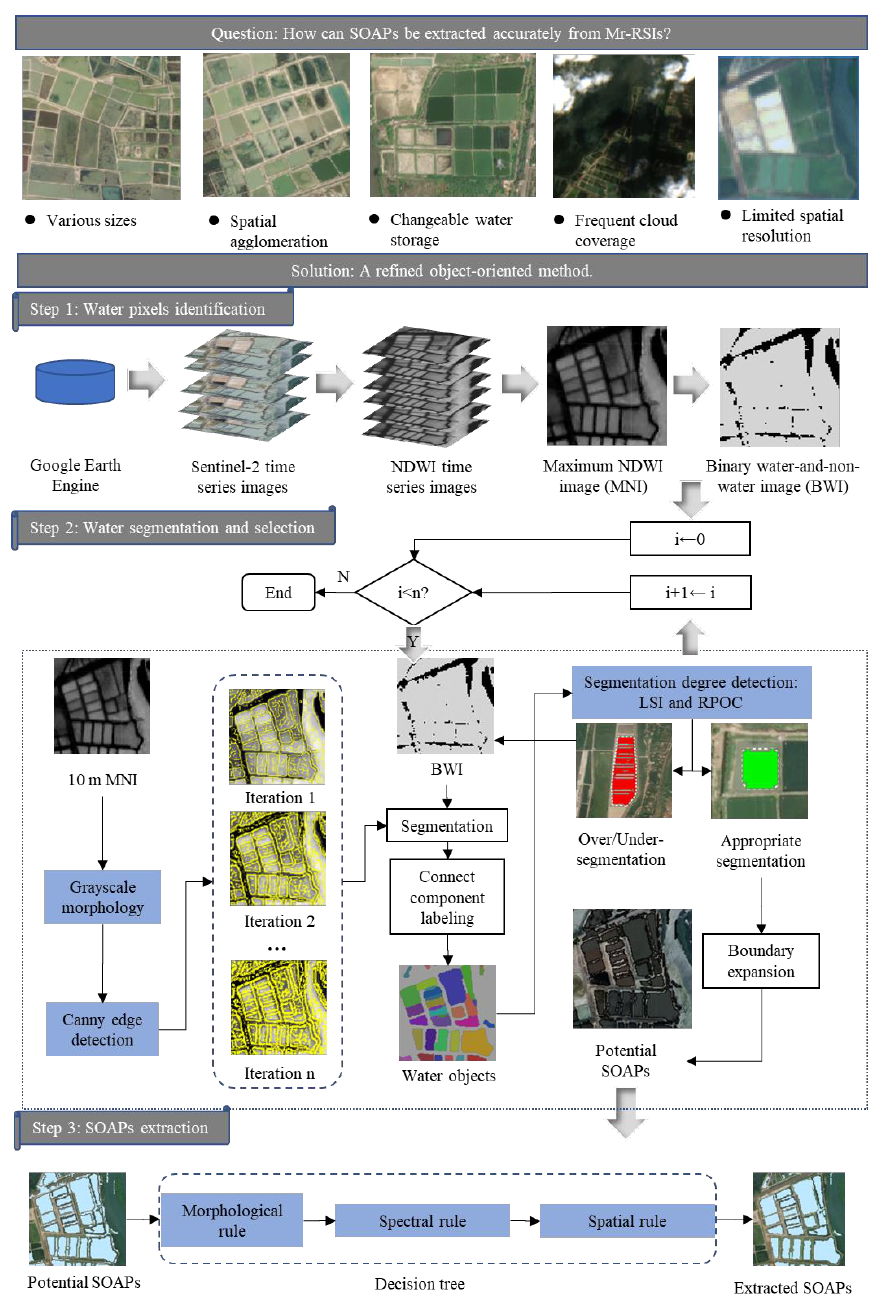
Figure 3. Framework of the proposed method for SOAPs extraction.